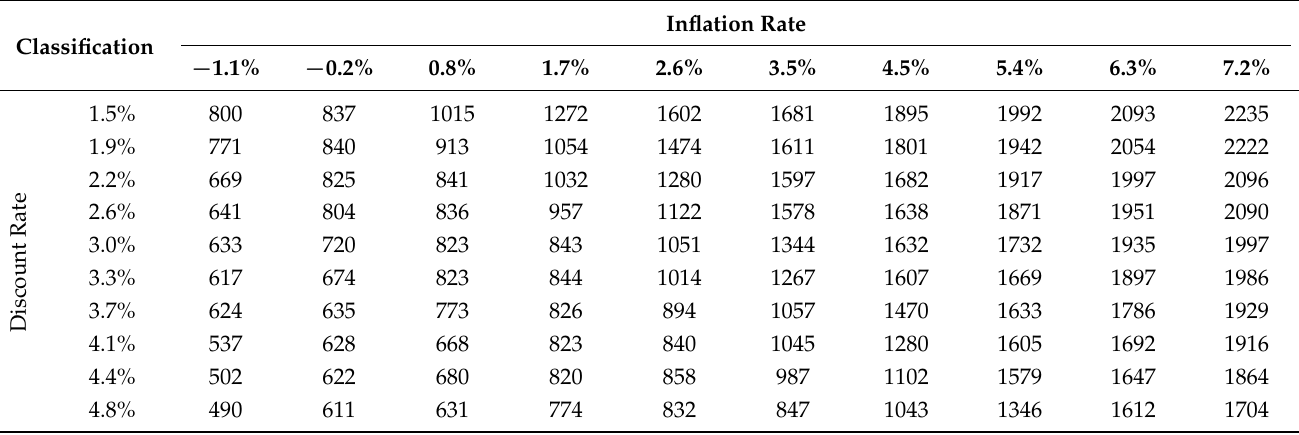
Table A3. The results of the sensitivity analysis of inflation and discount rates: